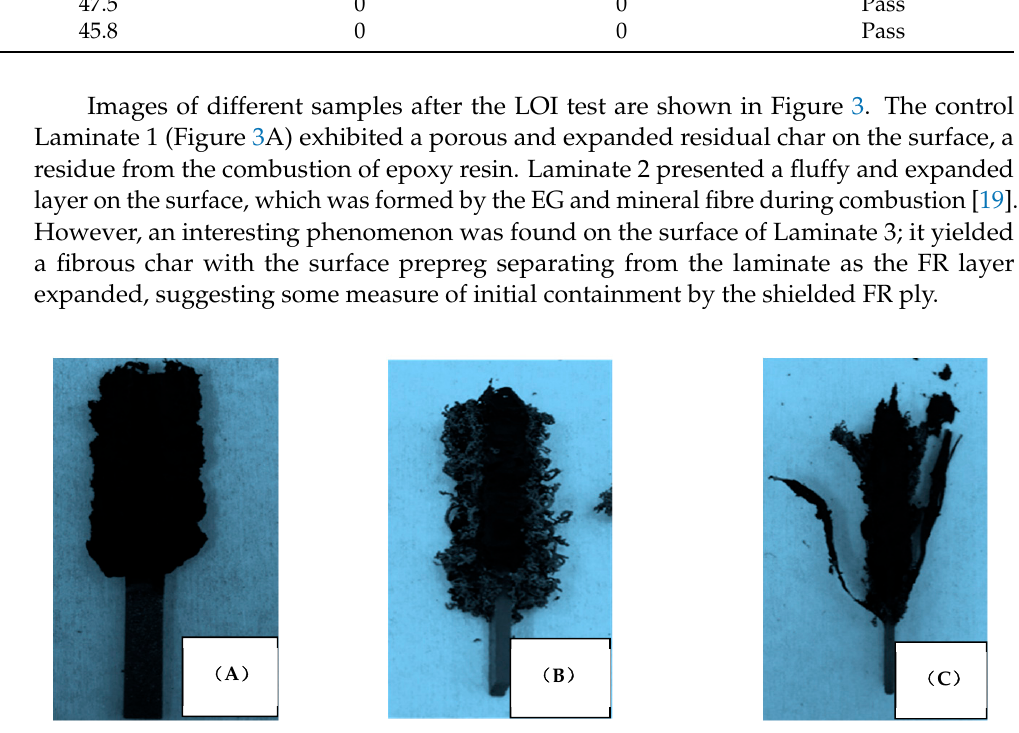
Figure 3. The images of the sample after LOI testing: ( A ) Laminate 1; ( B ) Laminate 2; ( C ) Laminate 3. The results of vertical burner tests are shown in Table 3, including flame time and drip time. The flame time and drip time have been recognized as the important parameters in composite fire resistance properties. Dripping in particular can lead to fire growth, at last increasing the fire hazard. The total flame time of the control Laminate 1 was 22 s with no dripping. Both Laminate 2 and Laminate 3 were self-extinguished, showing no flame time and dripping, and subsequently the location of the FR layer made no difference. The images of composites after vertical burning testing are presented in Figure 4. Laminate 1 showed the phenomenon of charring, while both Laminate 2 and Laminate 3 demonstrated some char expansion, attributed to the EG